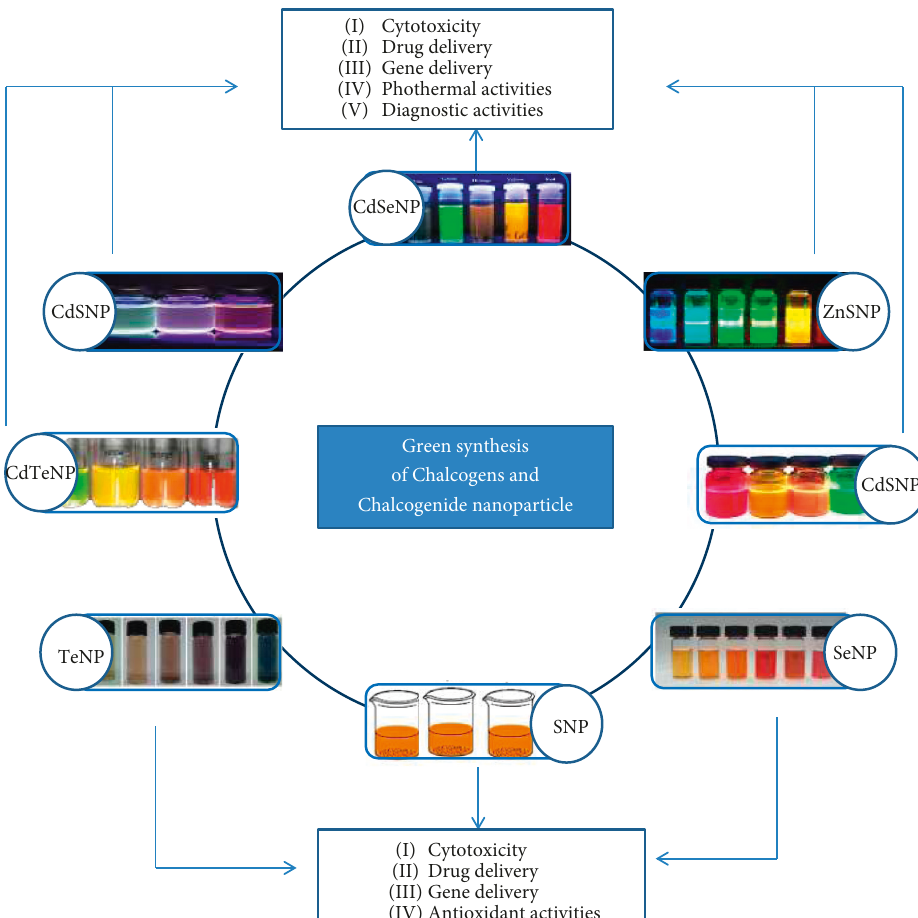
Figure 1: Green synthesized chalcogens and chalcogenide nanoparticles and their applications. NP � nanoparticle, Cd � cadmium, Se � selenium, S � sulfur, Zn � zinc, and Te �